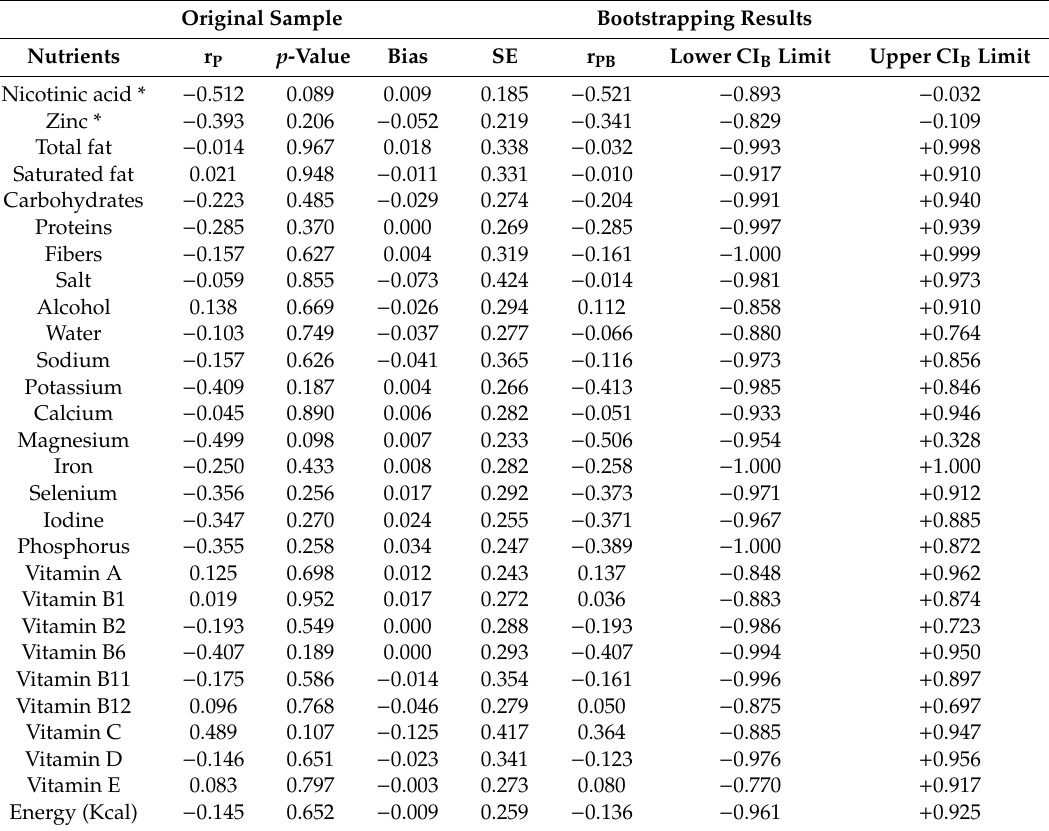
Table 2. Association between dietary nutrient intake (two-day average) and overall hangover